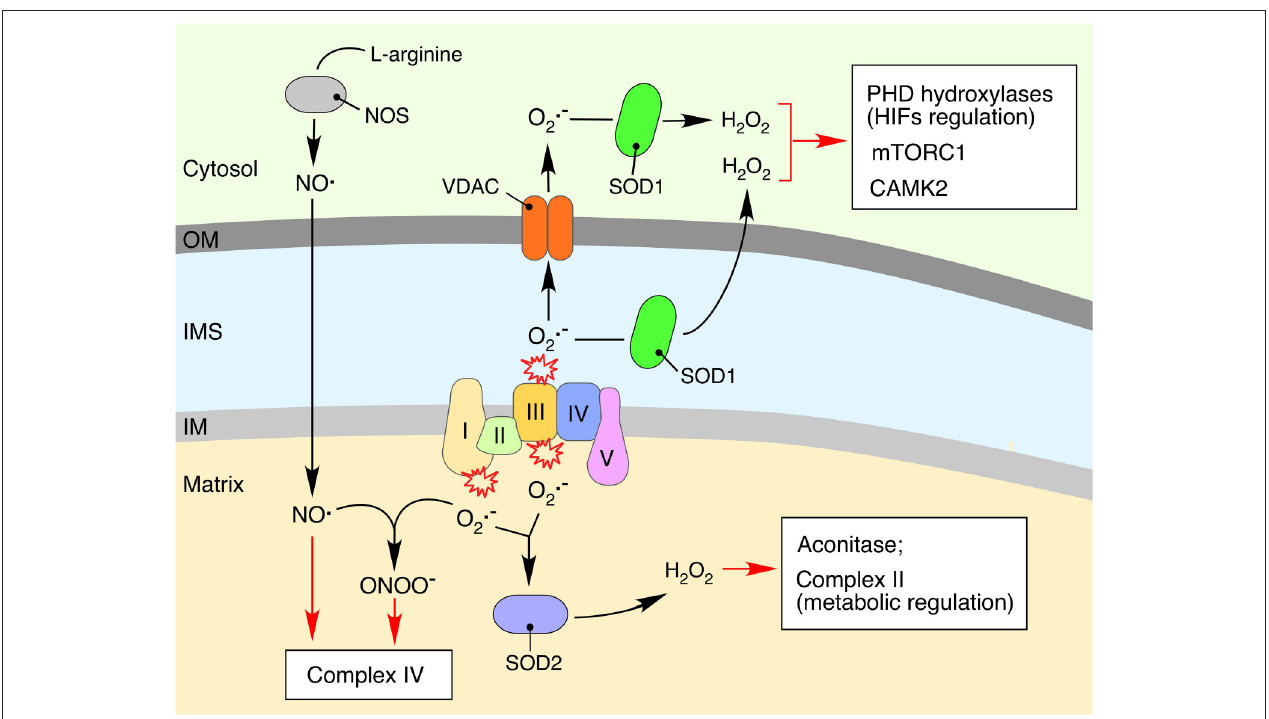
FIGURE 2 | Impact of mitochondria-derived free radicals on cellular signaling processes. Reduction of molecular oxygen to the superoxide anion (O ·− 2 ) is an unavoidable consequence of electron leakage associated with the bioenergetic function of respiratory complexes ( Figueira et al., 2013). The O ·− 2 produced is quickly converted to hydrogen peroxide (H 2 O 2 ) by the mitochondrial matrix-associated manganese (SOD2) or inner membrane space (IMS)-localized copper-zinc (SOD1) superoxide dismutases (Murphy, 2009; Figueira et al., 2013). Accumulation of H 2 O 2 can affect functioning of mitochondrial proteins, in particular those containing iron-sulfur clusters. Aconitase, a key component of the TCA cycle, is one of the mitochondrial proteins most susceptible to oxidative damage due to the surface exposed iron-sulfur cluster-containing active sites ( Armstrong et al., 2004). Mitochondria-derived O ·− 2 and H 2 O 2 can also impact cytosolic signaling cascades via oxidation of various redox-sensitive proteins including calcium/calmodulin-dependent protein kinase 2 (CaMK2) (Erickson et al., 2008), the mammalian target of rapamycin complex 1 protein kinase (mTORC1), and PHD hydroxylases ( Sena and Chandel, 2012). The cytosol-derived nitric oxide radical (NO . ), a product of arginine conversion by nitric oxide synthases (NOSs), can permeate mitochondrial membranes and inhibit electron transport chain functioning through competitive inhibition of respiratory complex IV or via condensation with O ·− 2 and formation of a potent oxidant, peroxynitrate (ONOO − ) ( Nisoli et al., 2003; Antunes et al., 2004; Figueira et al., 2013